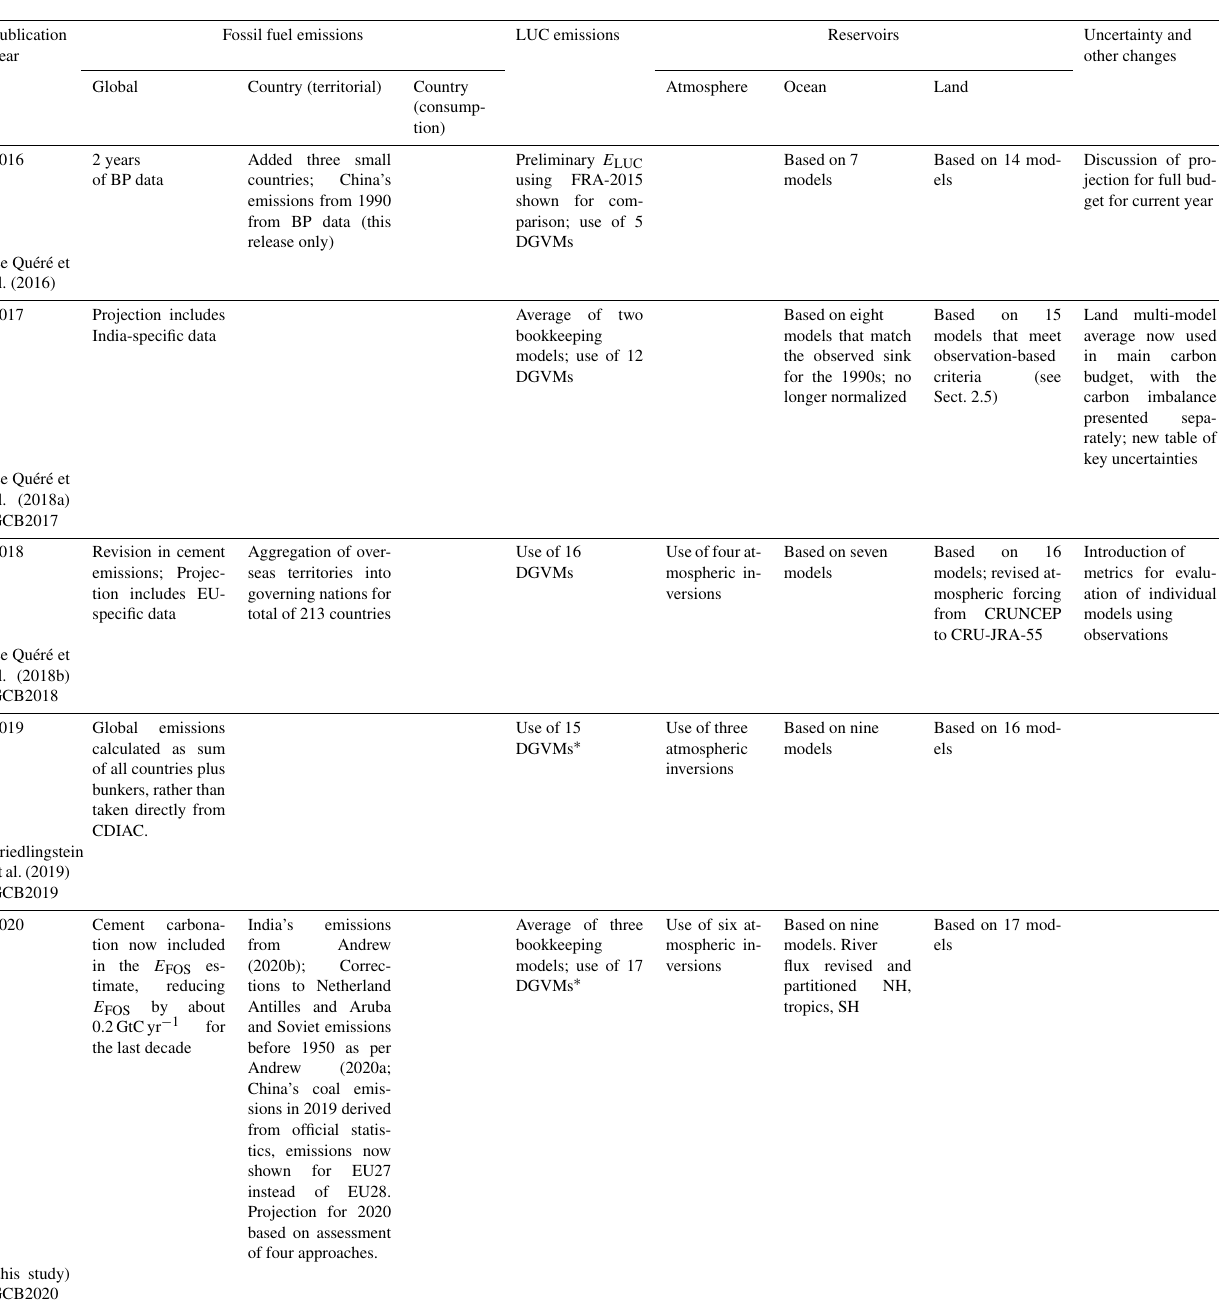
Table 3. Main methodological changes in the global carbon budget since 2016. Methodological changes introduced in one year are kept for the following years unless noted. Empty cells mean there were no methodological changes introduced that year. Table A7 lists methodological changes from the first global carbon budget publication up to